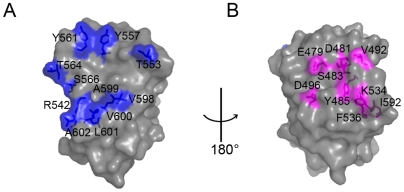
Mapping of site-directed mutation on E2s.A transparent surface representation of the subunit of the E2s dimer is shown at two different orientations. (A) Shows the dimerization mutants and (B) shows the groove region mutants. Figure 6(B) is 180° rotated with respected to Figure 6(A). Further the view of Figure 6(A) is related to the view of Figure 1(A)
 with an anticlockwise rotation of 90°. All mutated residues are shown in ball and stick model. Residues playing roles in the E2s dimerization are shown in blue. Residues in the groove region that were mutated to study the reactivity of mAb are shown in magenta. This figure was prepared using PyMol [34].